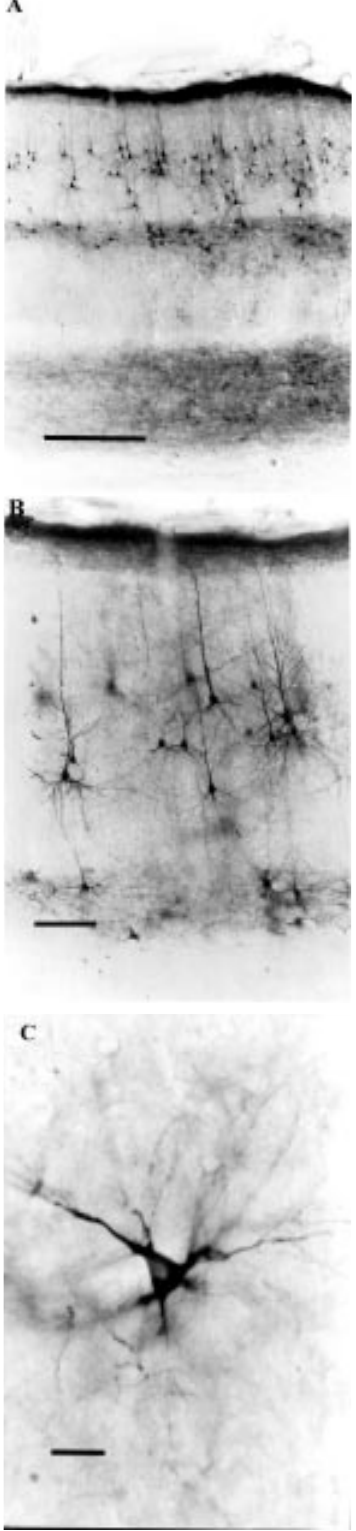
Figure 3 - Photomicrographs of retrogradely labeled cells of V1 after implanting biocytin gels. A , Low power photomicrograph il- lustrating two distinct rows of labeled neurons in the superfi- cial and deep portions of layer III. Scale bar = 400 µm. B , High power photomicrograph show- ing different size pyramidal cells in the superficial sublayers (IIIa and IIIb). Scale bar = 100 µm. C , Typical stellate cell from layer IIIc (IVb). Scale bar = 20